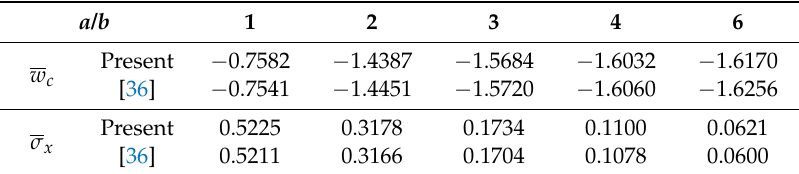
Table 2. Maximum deflection w c and stress σ x versus length-to-width ratio ( a / h = 10). a /